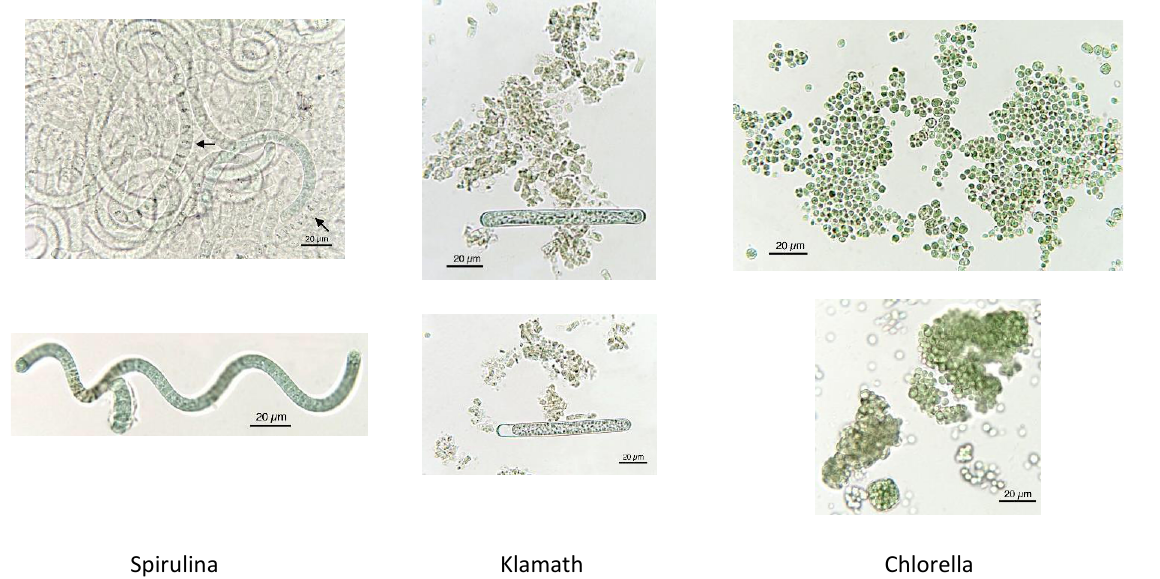
Figure 7. Microscopic characteristics of each microalga, allowing for identification.